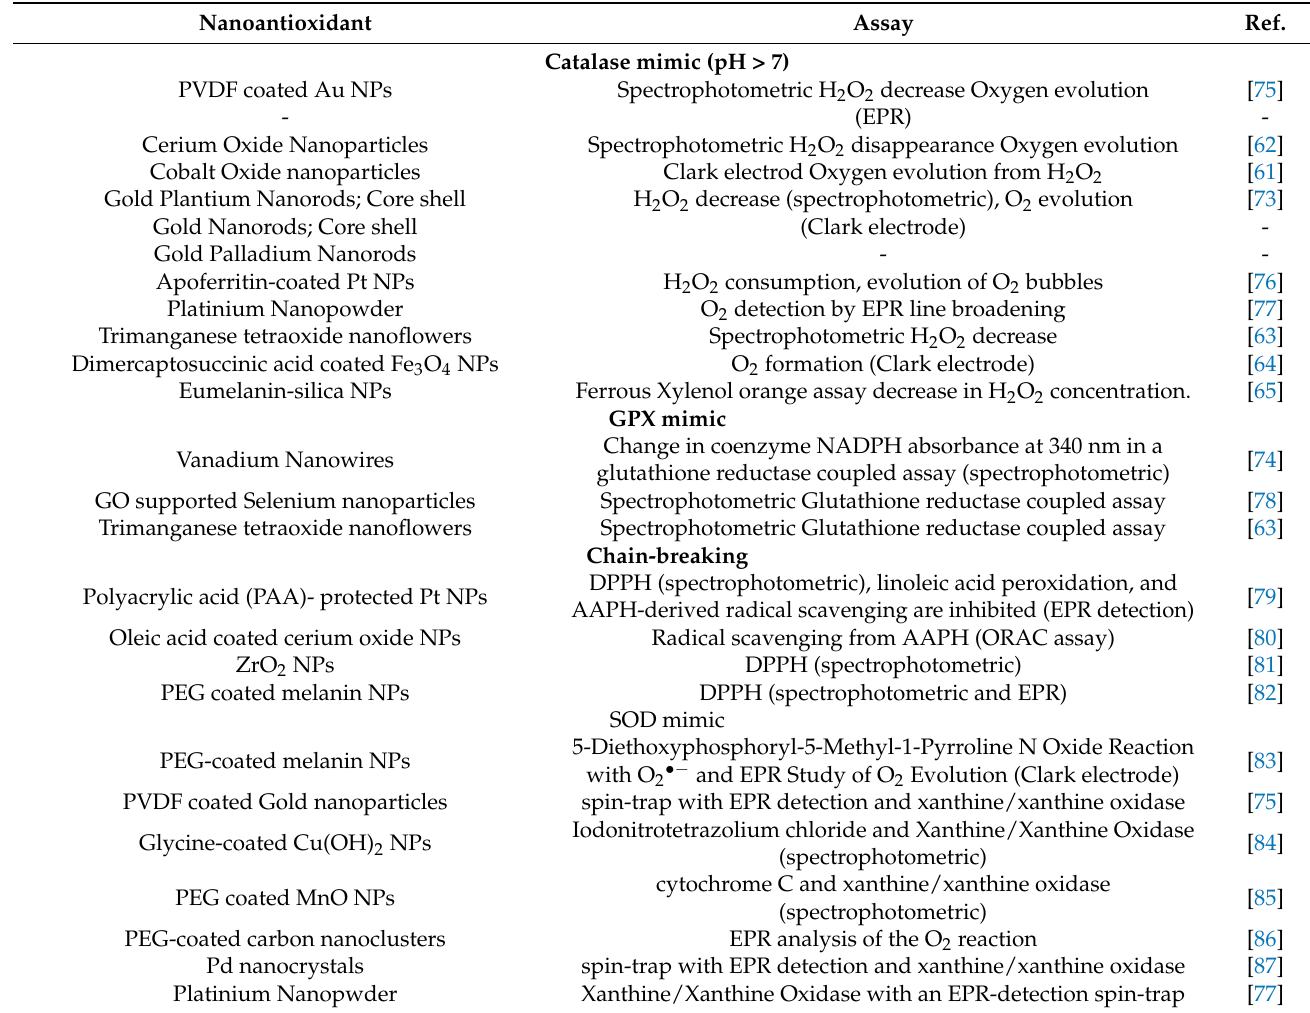
Table 1. Mechanisms of Action and Chemical Assays for Evaluating the Activity of Antioxidant